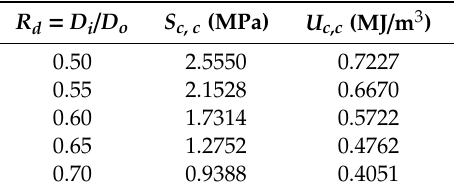
Table 2. Measured mean values of compression strength and compression toughness for five rubber fenders with di ff erent wall